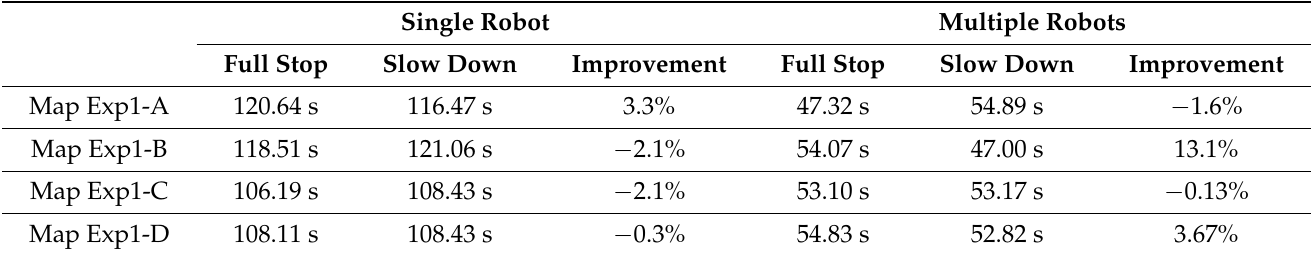
Table 1. The comparison of the exploration time when the robot performs a full stop or slows down before making turns. Single Robot Multiple